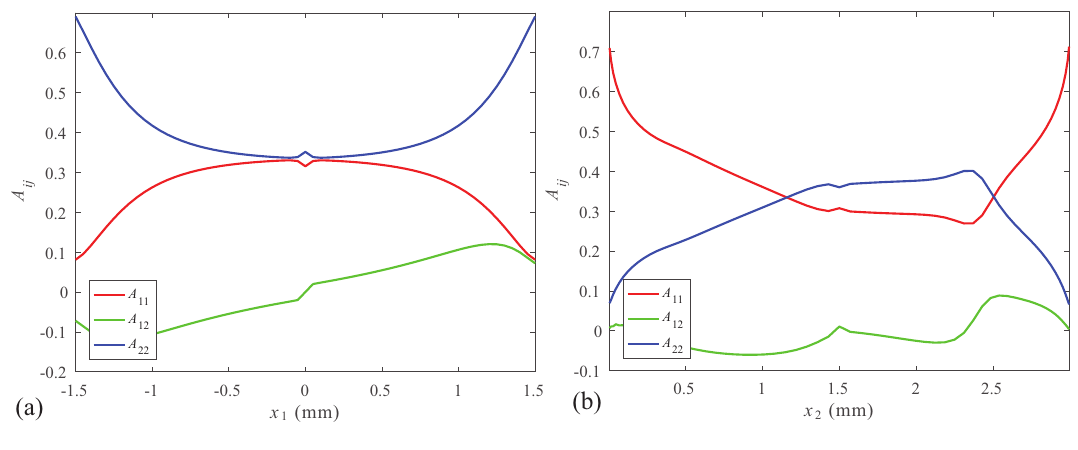
Figure 9. Orientation tensors calculated from the IRD-RSC model with C I = 10 − 2 and κ = 1/30. ( a ) A ij as a function of x 1 at the nozzle exit and ( b ) A ij as a function of x 2 within the deposited bead.